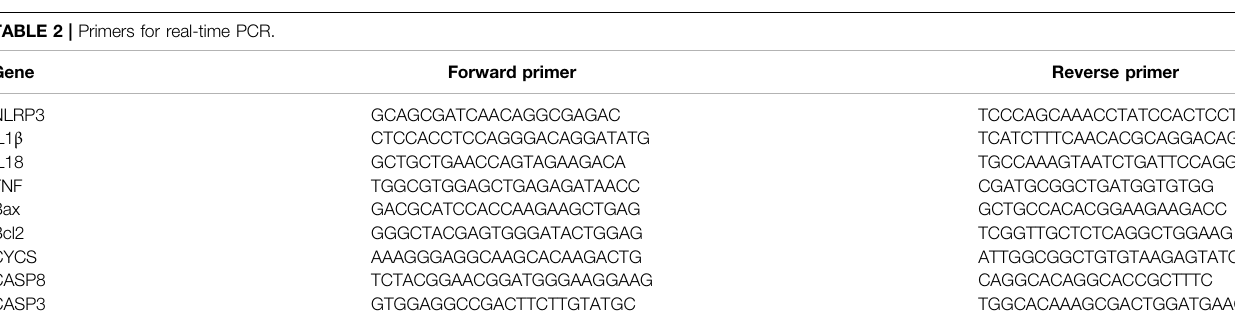
TABLE 2 | Primers for real-time